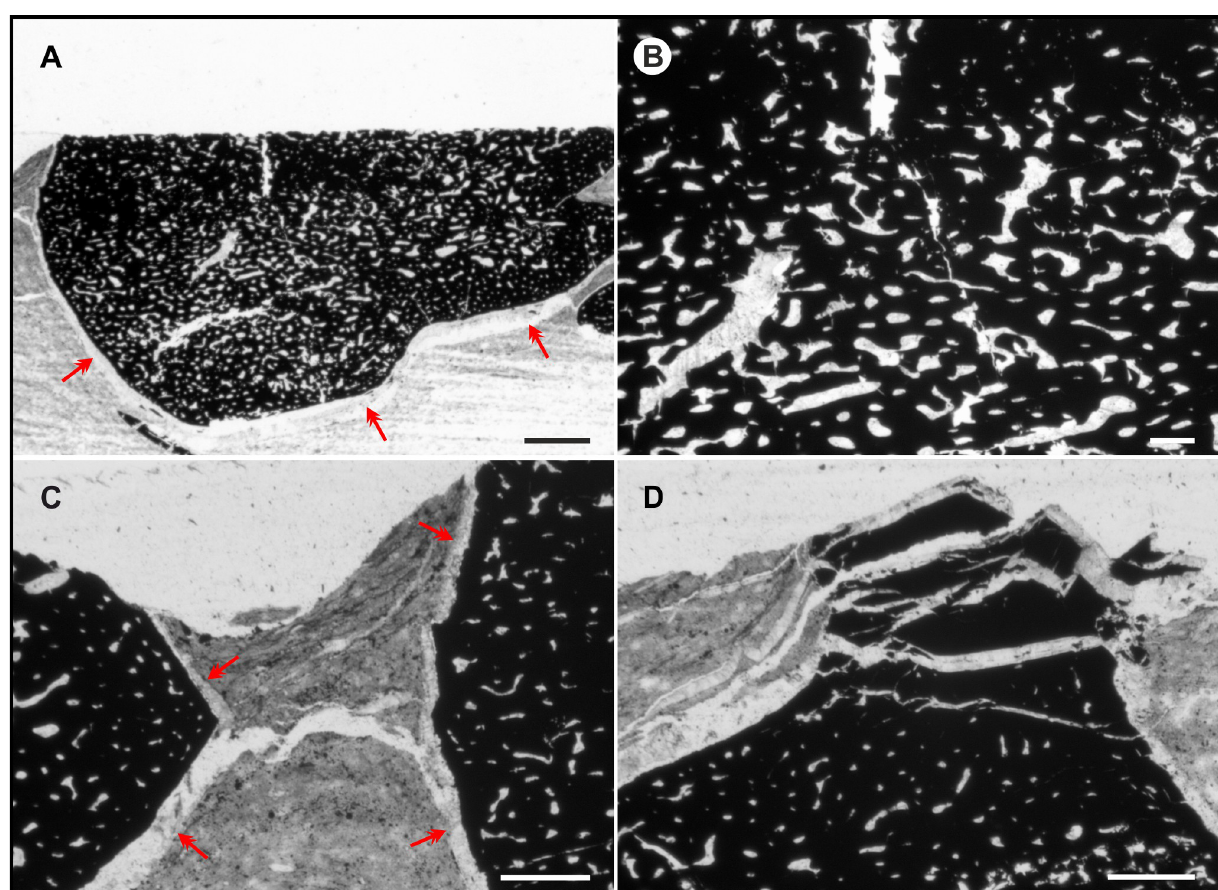
Fig 5. Analyses carried out on specimen NHMW 2012/0117/0024. (A) Thin-section of enigmatic black fossil reveals a widely distributed channel system (grey); red arrows: surrounding calcitic seam/layer. Note the curving of sediment around the fossil specimen. (B) Magnification showing pore space in the center of the fossil. (C) Red arrows mark the outer seam surrounding the fossil. (D) Diagenetic cracks in the black fossil structure. All scale bars 200 μ m, except scale bar for A 500 μ m.